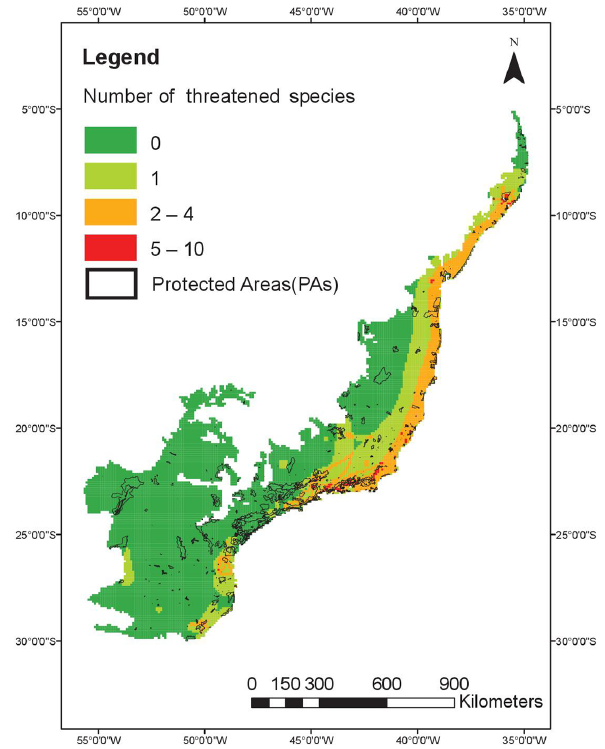
Figure 1. Map of protected areas network and geographical range of the threatened amphibian species that occur in the Brazilian At- lantic